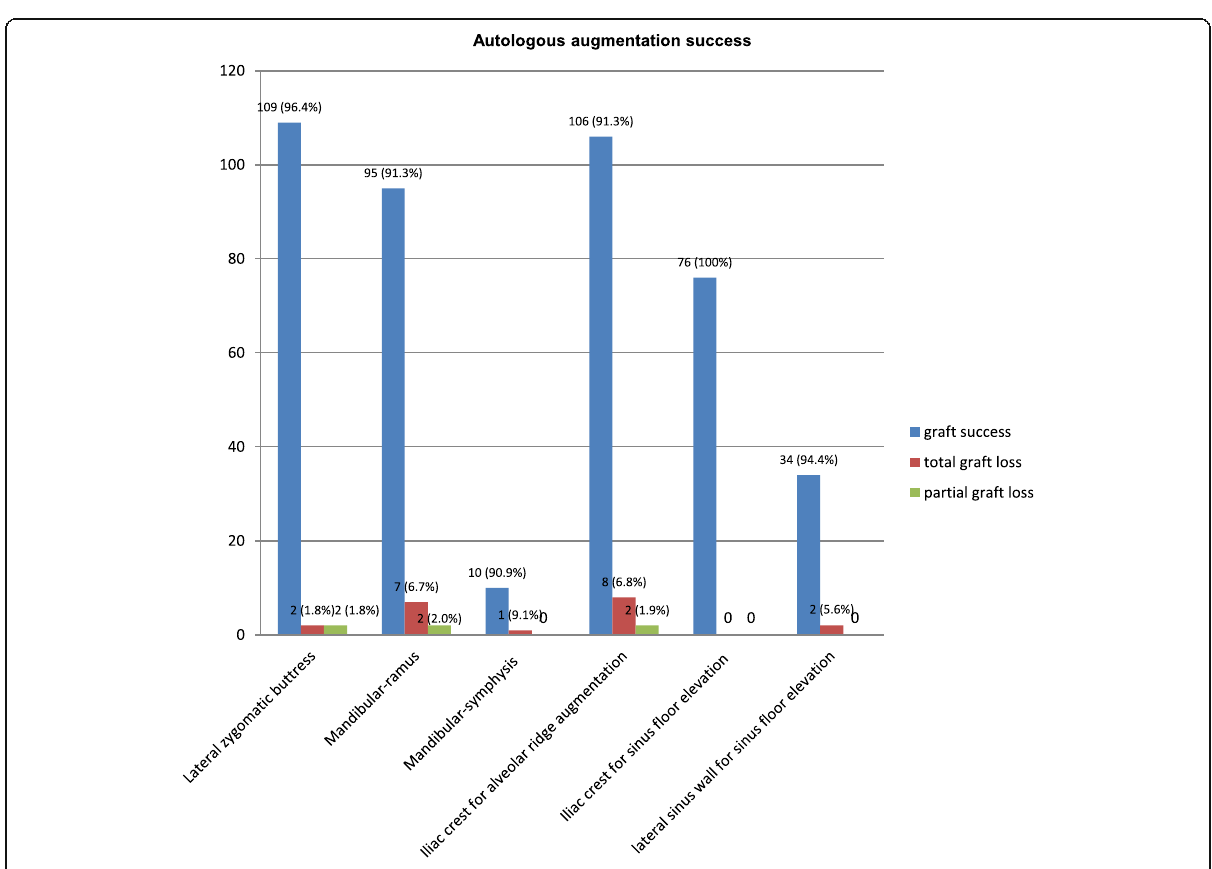
Fig. 3 Surgical outcome after autologous augmentation procedures from different donor